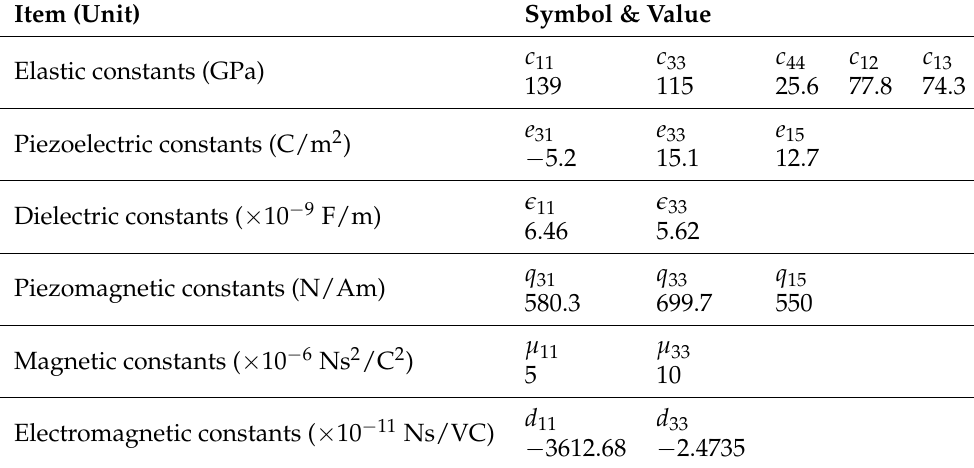
Table 1. Material properties of the nonhomogeneous magneto-electro-elastic half-space [40] at z = 0. Item